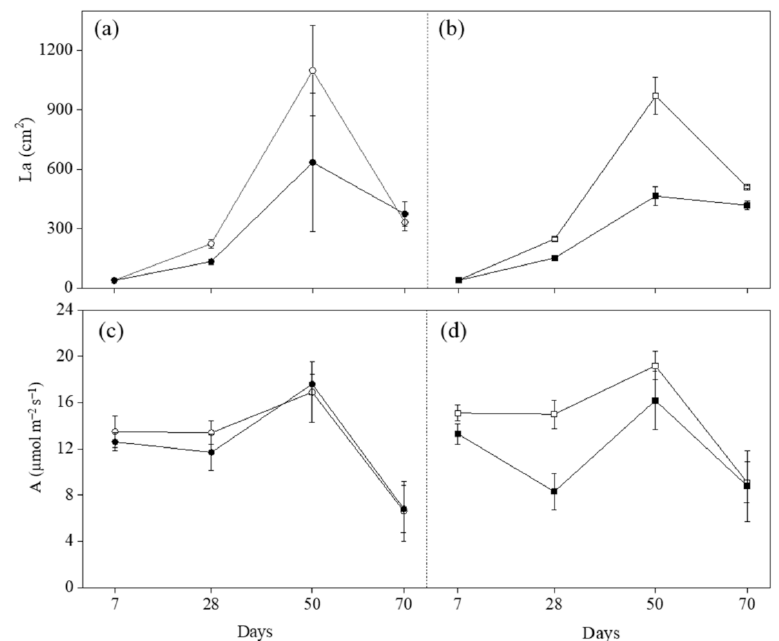
Figure 1. Leaf area (La) ( a , b ) and CO 2 assimilation rate (A) ( c , d ) in durum wheat cultivars Claudio (circle, left ) and Mongibello (square, right ) exposed to 0 (open) or 80 (closed) ppb of ozone (5 h day − 1 ) at different growth stages (7, 28, 50, 70 days from the beginning of exposure). Data are shown as mean ± standard deviation (n = 3). A vertical dashed line separates the cultivars.